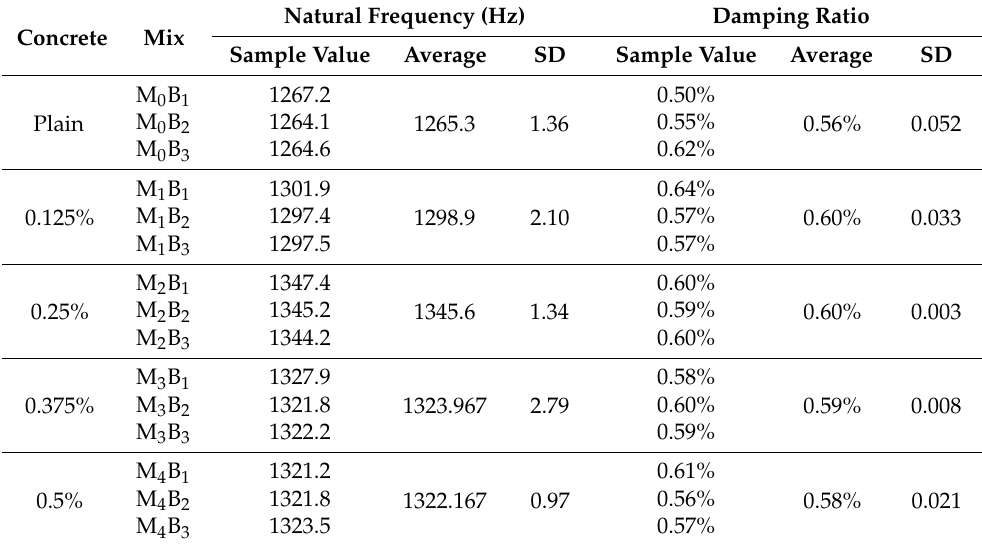
Table 6. The result of the modal test.